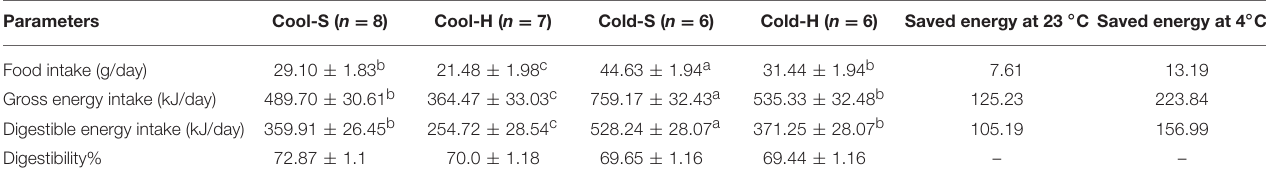
TABLE 1 | Body mass adjusted food intake, gross energy intake, digestible energy intake, and digestibility in groups of Brandt’s voles under different T a and grouping conditions.